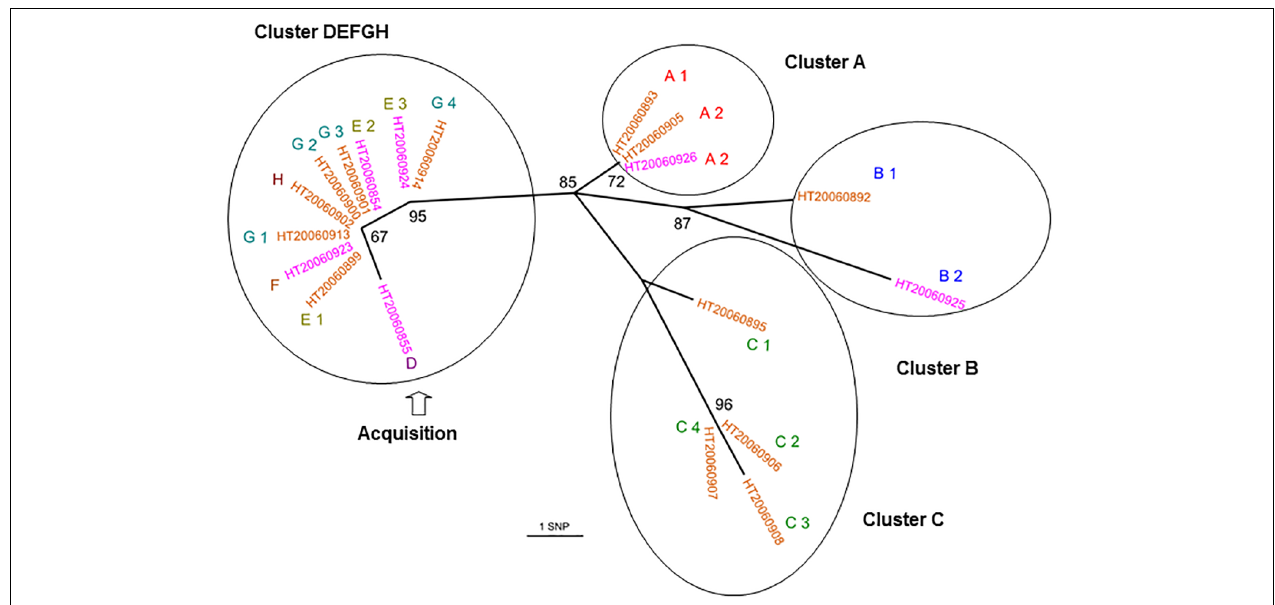
FIGURE 3 | Whole-genome sequencing reveals both inter- and intra-family transmissions for a CC30-MSSA community outbreak. Unrooted joining tree of 19 PVL-positive CC30 MSSA isolates of t1848 spa type from eight families. Family origins are labeled with an upper case letters (A, B, C, D, E, F, G, and H) near the strain identifier and subscripts (from 1 to 4) indicate a different family member. Carriage isolates are labeled in orange and infection isolates are labeled in purple. Circles enclose clusters of isolates (0–6 SNPs). The node numbers are bootstrap scores based on 100 repetitions. The scale represents the number of SNPs in 1,328 core genes. The D isolate had an extended branch length that could explain that he was the